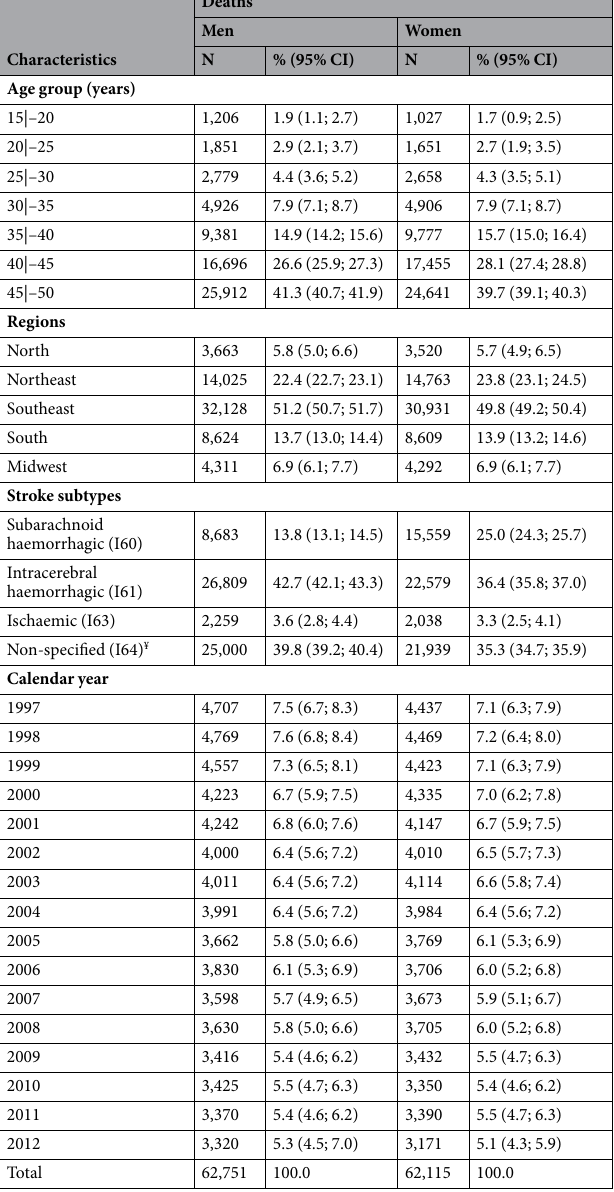
Table 1. Frequency of deaths from stroke * in Brazilian men and women aged 15 to 49 years between 1997 and 2012. 95% CI: 95% confidence interval. * International Statistical Classification of Diseases and